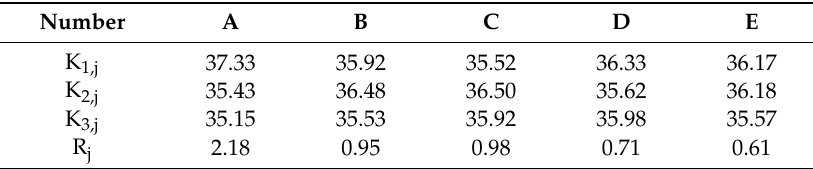
Table 19. Range analysis of strength test